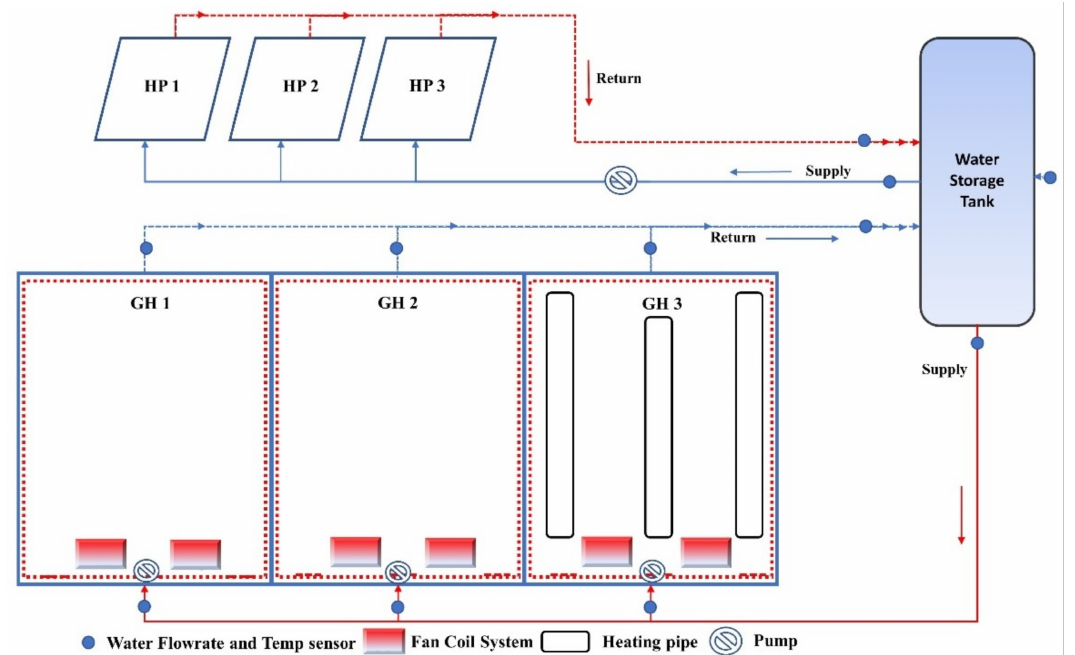
Figure 5. Schematic diagram of AWHP and location of the